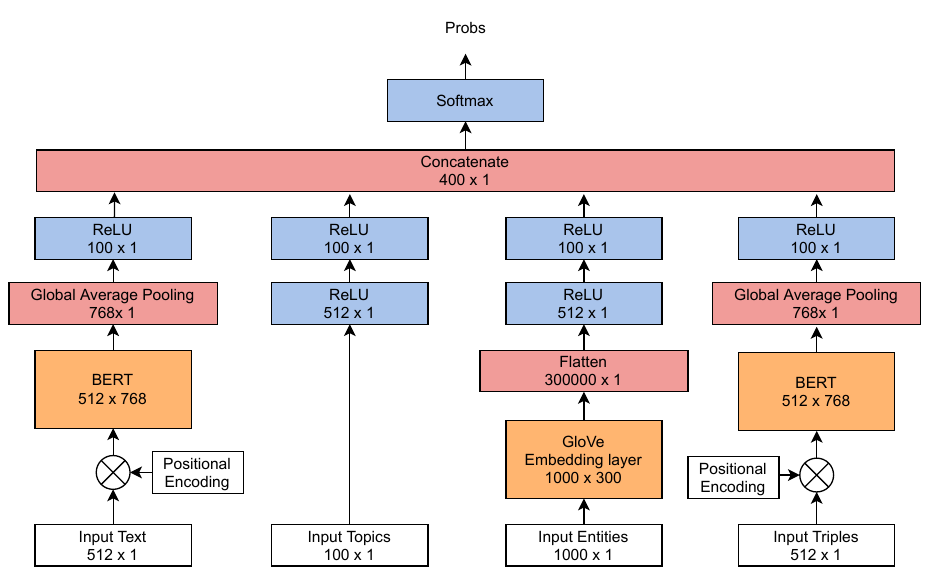
Figure 5. Deep learning architecture for classification of news-feeds with BERT using text, topics, named entities, and